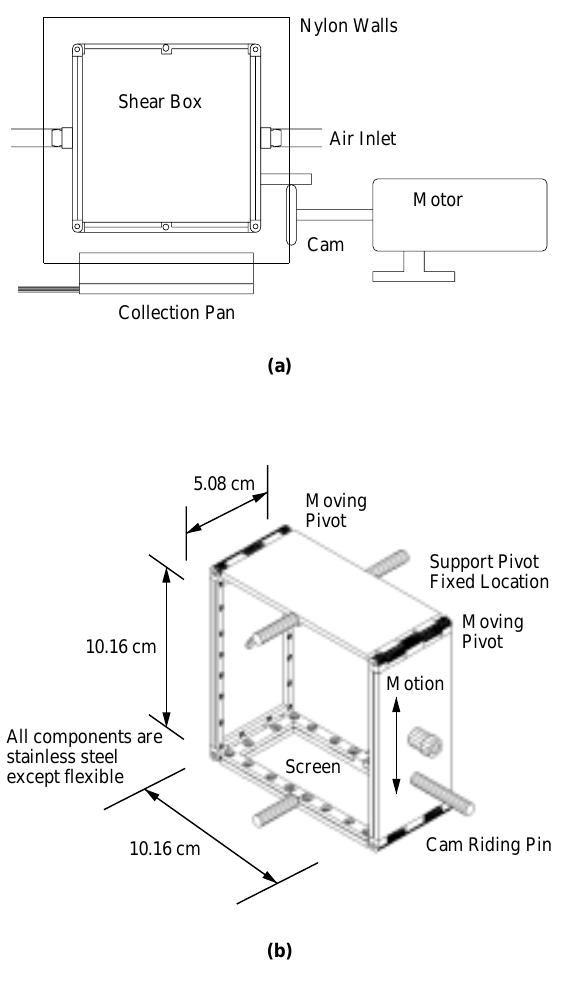
Vertically oriented primary segregation shear cell (a) over- all schematic, and (b) 3D